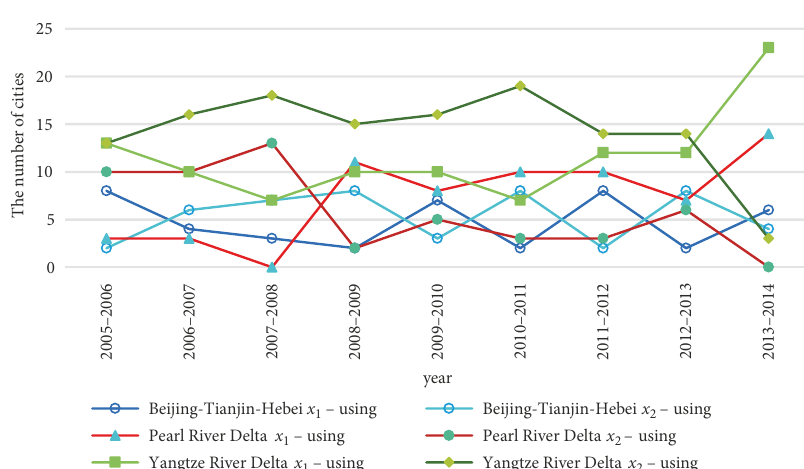
Figure 8. Input biased technological changes of capital stock ( x 1 ) and labor ( x 2 ) in each of the urban